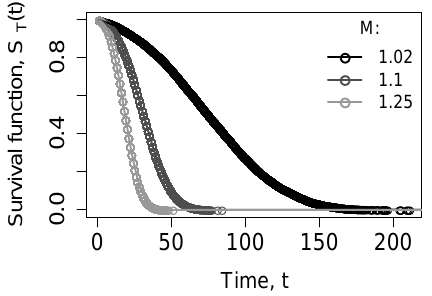
Figure 3. Cumulative hazard function H(t) for the nonstationary GP2 model, with a fixed C x = 0.75 for a range of trend values ( M = 1, 1.02, 1.1, 1.25); panels show two different size exceedance events: (a) p o = 0.002 and (b) p o = 0.001.